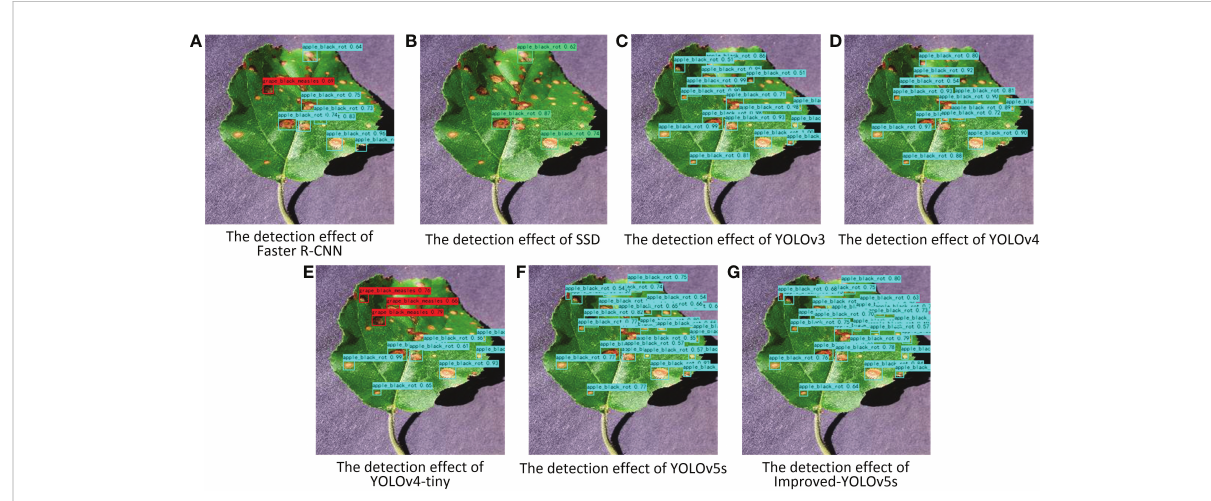
FIGURE 8 Pictures of the detection effect of apple black rot with different target detection models. (A – G) represent different target detection models.